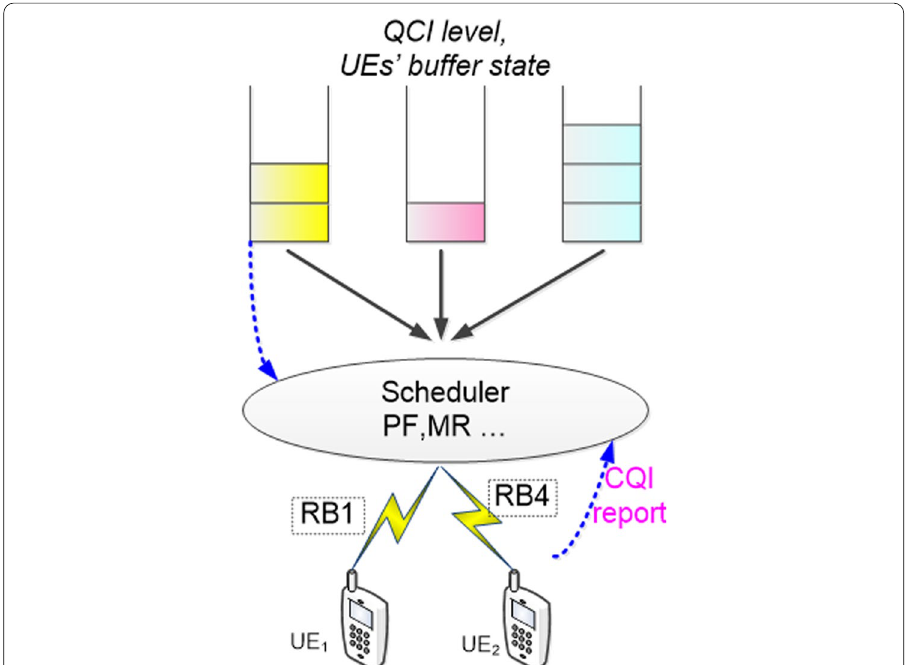
Fig. 1 Diagram of LTE scheduler; Per UE’s CQI state for each RB should be considered simultaneously in LTE MAC layer resource